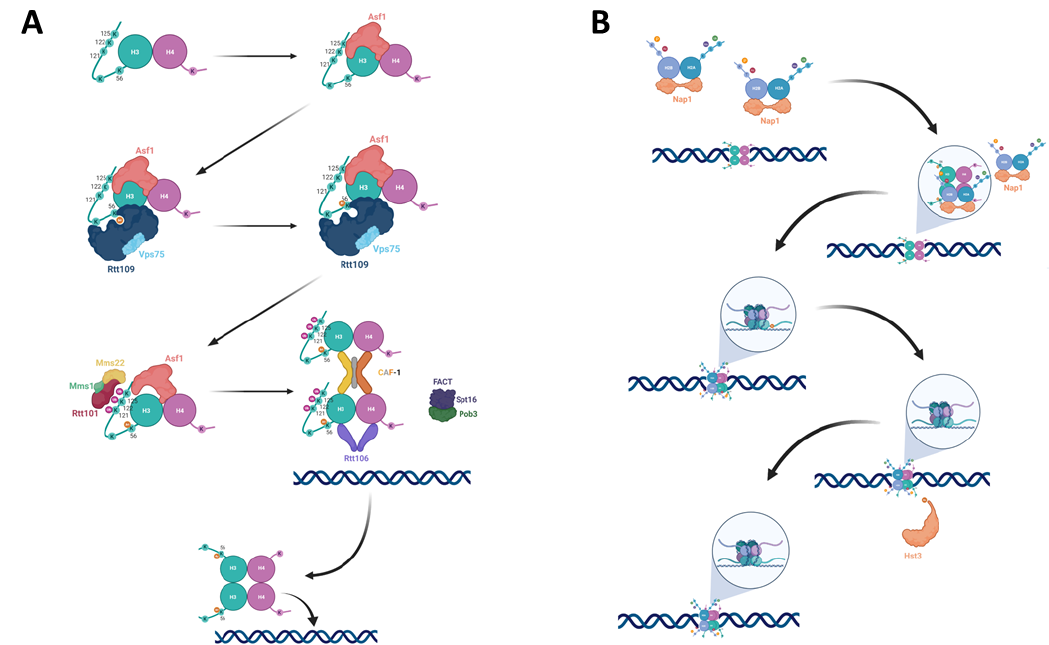
Figure 1. Nucleosome assembly with H3 K56-acetylated histones: ( A ) The newly synthesized H3-H4 dimer is bound by Asf1, which presents it to Rtt109. Rtt109, together with Vps75, acetylates H3 at lysine 56. The H3K56Ac-H4 dimer’s affinity to Rtt101 increases, leading Rtt101-Mms1-Mms22 to ubiquitylate H3 at K121, K122, and K125 of H3, and driving the dissociation of H3K56Ac-H4 from Asf1 and its handoff to the chromatin remodelers CAF-1, Rtt106 and FACT. ( B ) Following the incorporation of a tetramer containing two H3K56Ac-H4 dimers, two Nap1 proteins bring H2A-H2B dimers to form an octamer. Following the formation of the octamer Hst3 then deacetylates the nucleosome at position K56 of H3.